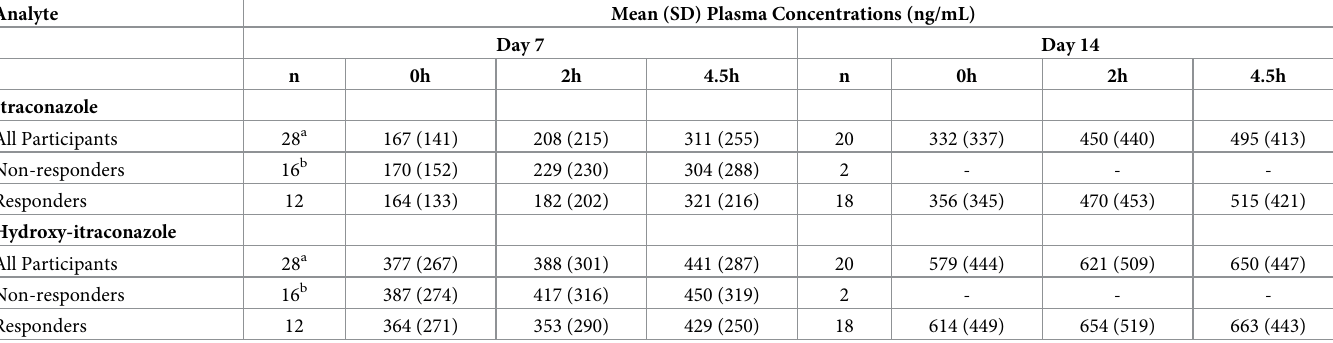
Table 3. Plasma concentrations of itraconazole and hydroxy-itraconazole following oral administration of 200 mg itraconazole once daily or reference itraconazole (PK analysis set).